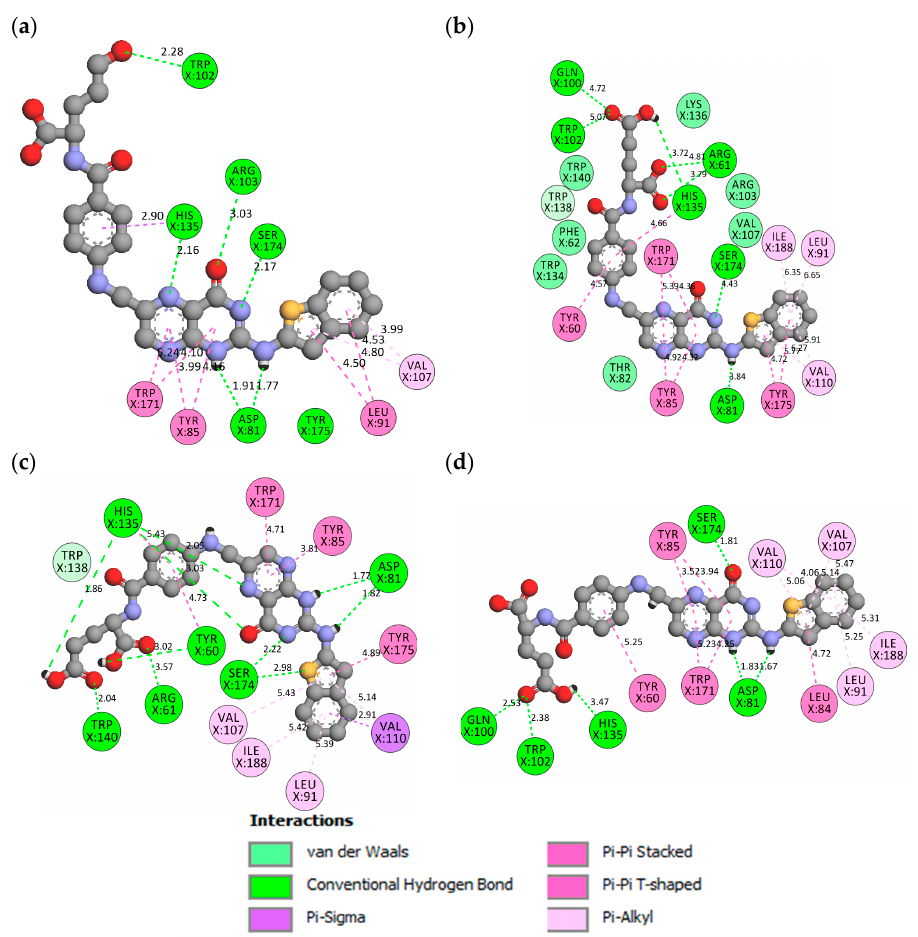
Figure 11. FOL08 orientations and its interactions with FR α during MD simulations at 30 ns ( a ), 45 ns ( b ), and 65 ns ( c ), and 95 ns ( d ). This model demonstrates the behavior of the FOL08 interaction with ASP81 and the location of the amino acids in the pocket of FR α .